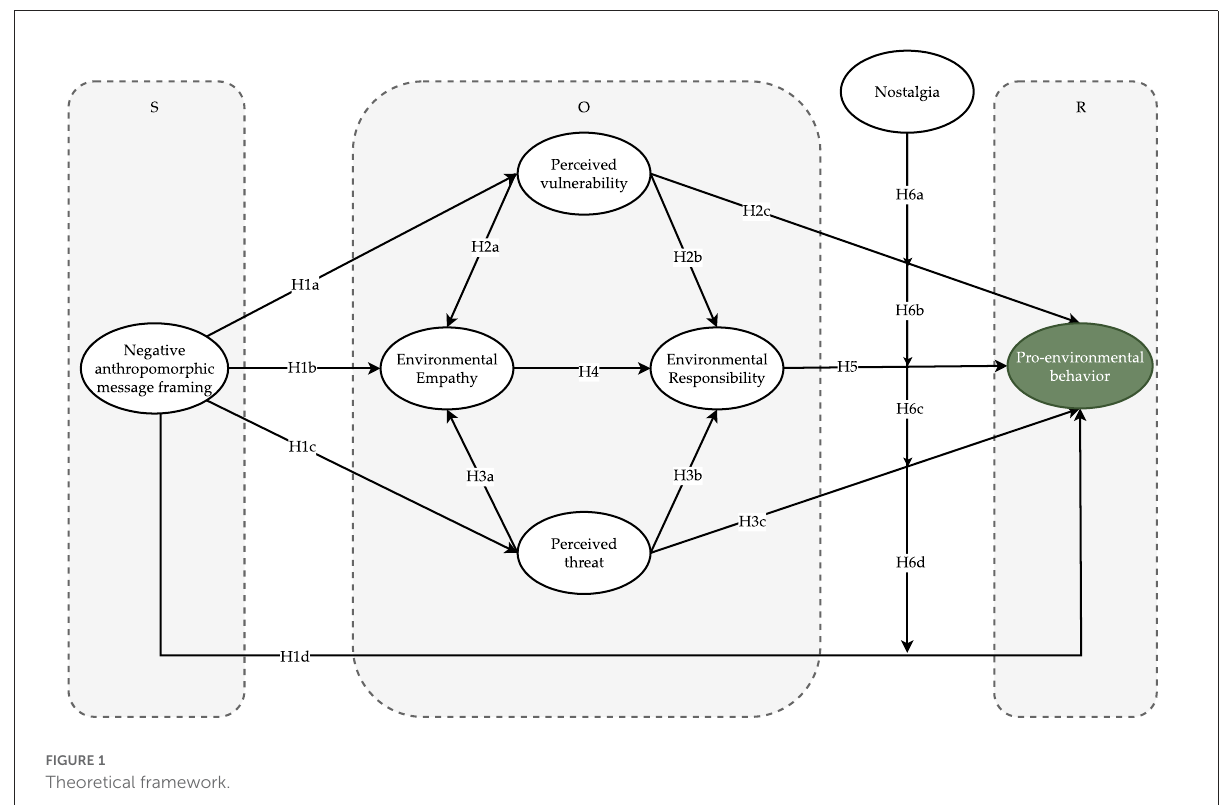
FIGURE1 Theoretical